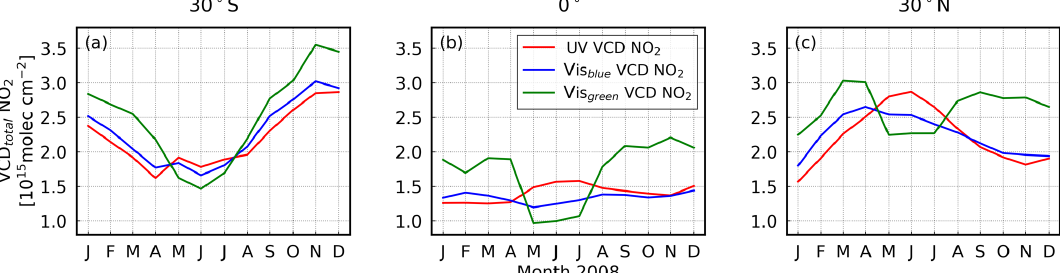
Figure 6. Time series of NO 2 total VCDs of 2008 for 30 ◦ S (averaged: 28–32 ◦ S), 0 ◦ N (averaged: 2 ◦ S–2 ◦ N), and 30 ◦ N (averaged: 28– 32 ◦ N) above the area of the reference sector for cloud-free